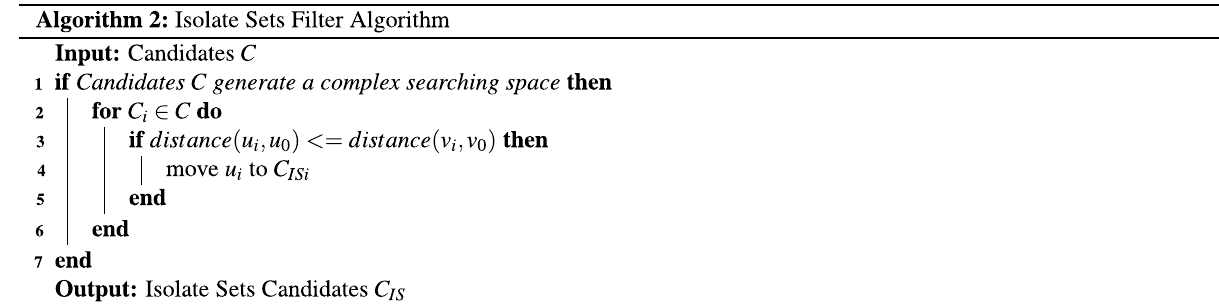
v v v 3 , 6 and 9